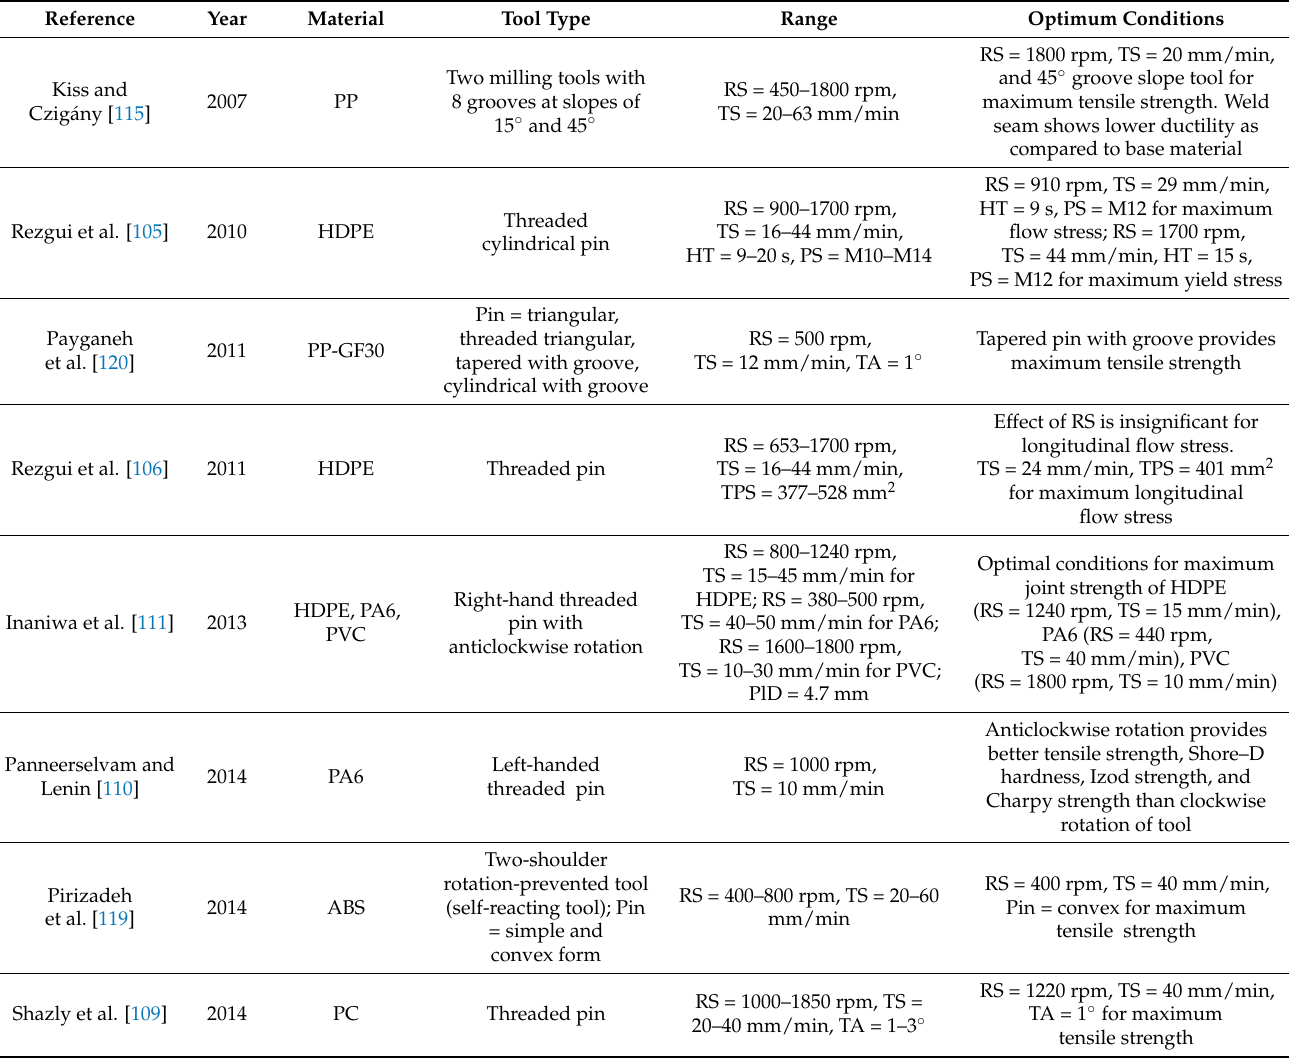
Table 3. Butt-joint FSW of thermoplastic polymer and polymer composite sheets with varying pin